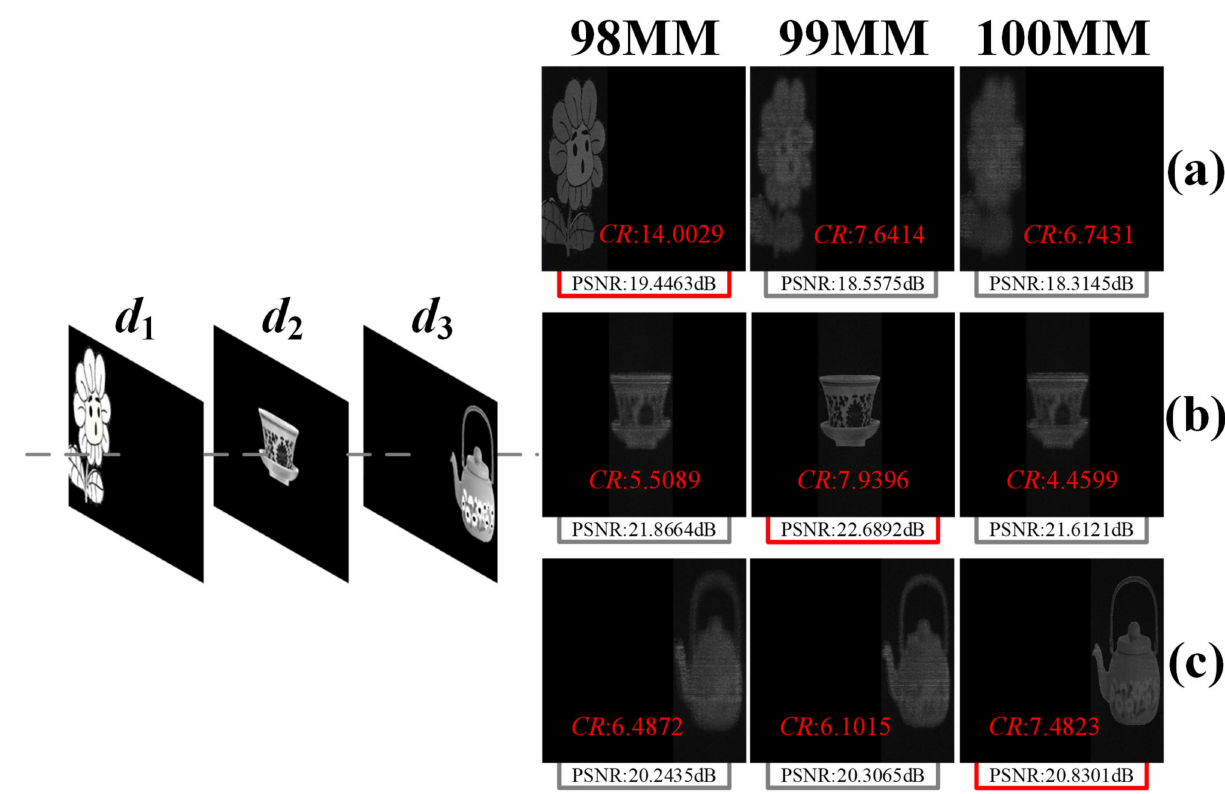
Figure 7. Testing the reconstruction of hologram images after inputting complex images. Each of the three input planes has a complex image at a different location, where the depth plane d 1 is closest to the hologram plane and the numerical reconstruction results are shown in rows ( a , b , c ) when the focusing plane is located in the depth planes d 1 , d 2 and d 3 , respectively. The PSNR and the CR in the corresponding focused depth plane are shown in the corresponding